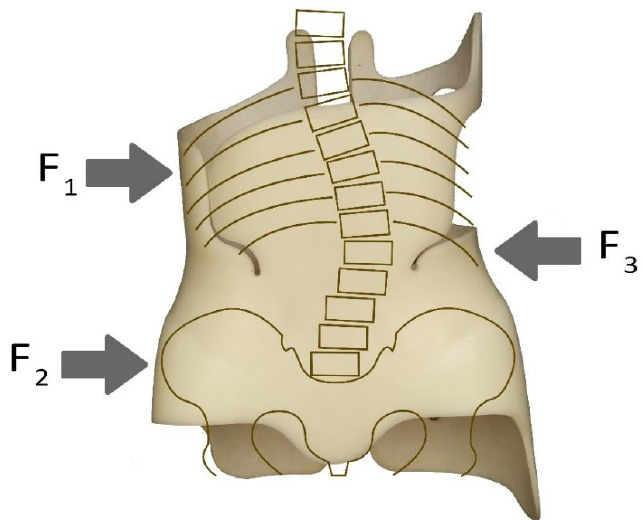
Figure 1. Boston brace—diagram of the left lumbar curve with a simplified correction scheme (view from front). Forces exerted by the brace: F 1 and F 3 —forces acting on the thoracic cage, F 2 —force applied to the pelvis.